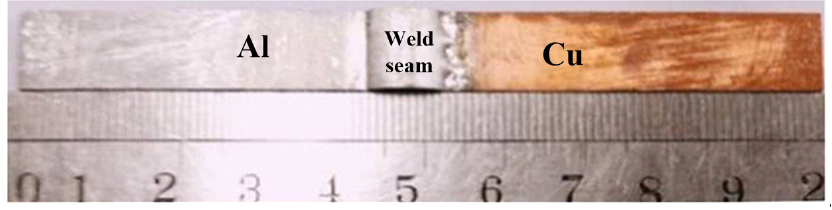
Figure 3. The specimen for testing conductivity.